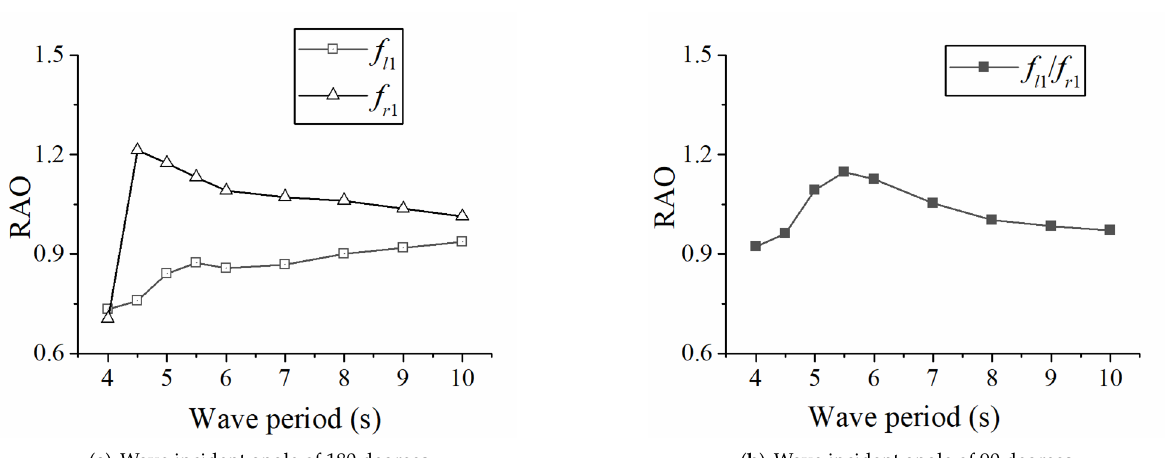
Figure 6. Sketch of floaters’ arrangement for different cases.